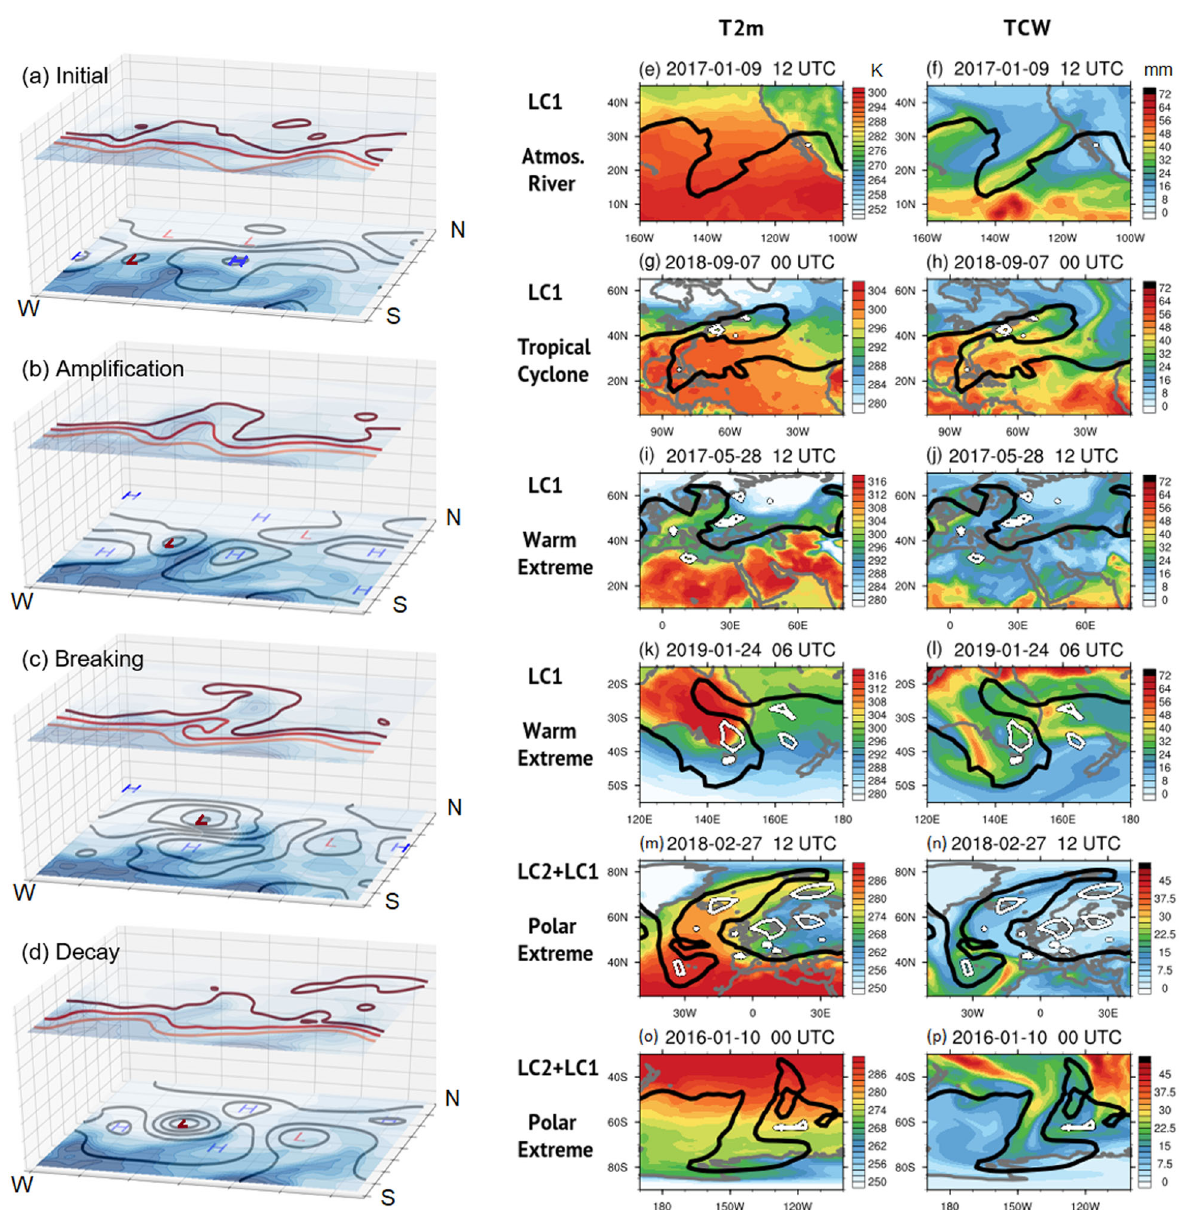
Fig. 1 Observed LC1- and LC2-type life cycle of baroclinic waves. The left column a – d shows the schematics derived from a real-world baroclinic wave. The upper-level contours show 350-K potential vorticity, the surface contours show sea-level pressure, and the blue shading shows column integrated water vapor. The wave is associated with a surface low (L) that develops ( a , b ) and moves poleward ( c ). The upper- level fl ow shows in LC2-type RWB in the Northwest and LC1-type RWB in the Southeast ( c ). This event contributed to an atmospheric river (dark blue plume) ( c ), a strong surface cyclone ( c ), and an upper-level blocking pattern (detached dark red feature) ( d ). The right two columns provide additional wave cases. Color shading shows 2-m air temperature (unit: K) and total column water (unit: mm), respectively. Black contours show 350-K potential vorticity (PV), while white contours denote small-scale PV features. The PV contours are ±1.5 PVU in subtropical cases and ±7 PVU in mid-/high-latitude cases. e , f LC1 event contributing to an atmospheric river landfall that ended a multi-year drought in California. g , h LC1 event steering weakened Hurricane Florence to the U.S. i , j LC1 event contributing to record-breaking heatwaves in Central Europe and Southwest Asia. k , l LC1 event contributing to a record-breaking heatwave in Southern Australia. m , n LC2 event (near 30°W) and LC1 event (near 15°E) contribute to extreme Arctic warming and a cold air outbreak in Europe. o , p LC2 event (near 160°W) and LC1 event (near 130°W) contribute to an Antarctic warm extreme event and ice